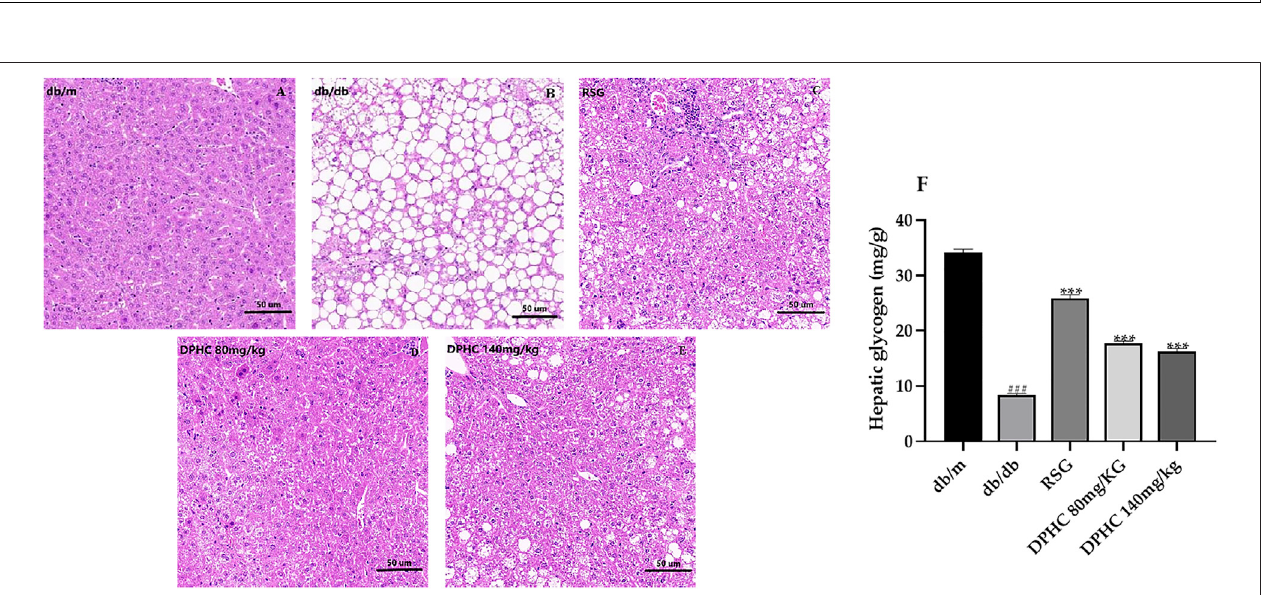
FIGURE4| EffectofDPHConseruminsulinlevelandantioxidantenzymesoflivertissuesindb/dbmice. (A) Seruminsulin. (B) HOMA-IR. (C) ISI. (D) MDA. (E) CAT. (F) SOD. (G) GSH-Px. All values are expressed as means ± SD, n (cid:1) 9. * p < 0.05, ** p < 0.01, *** p < 0.001 compared with the db/db group, and ## p < 0.01, ### p < 0.001 compared with the db/m group.